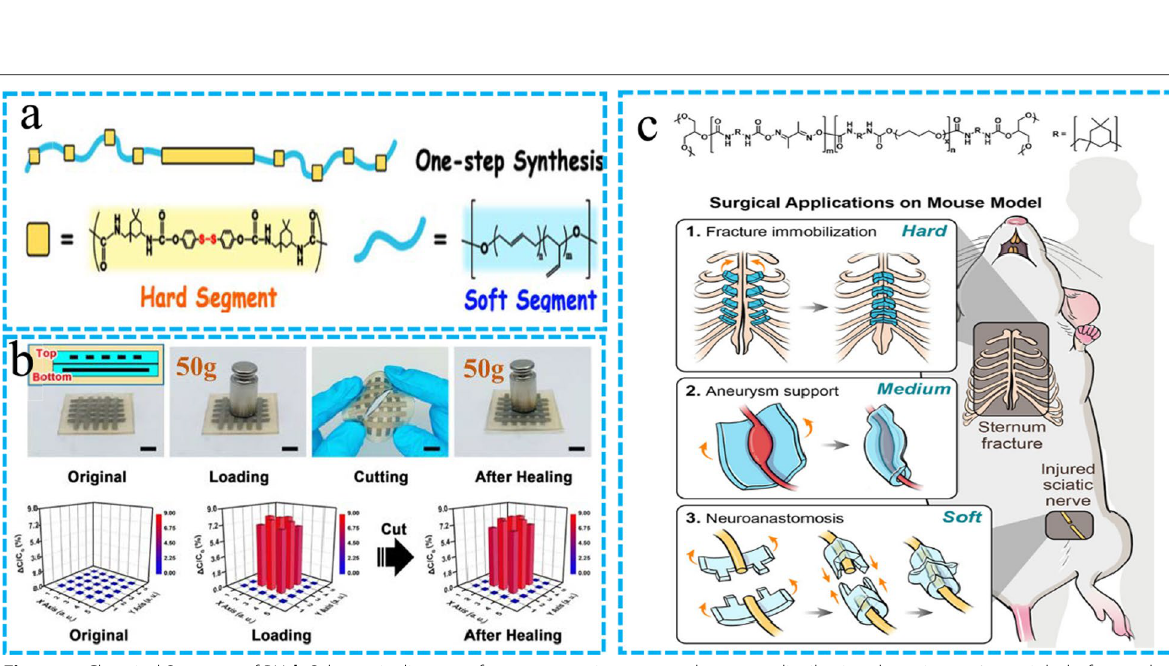
Fig. 15 a Chemical Structure of PU. b Schematic diagram of pressure sensing array and pressure distribution detecting a 50 g weight before and after self-healing. Reprinted with permission form Reference[86]. Copyright 2020, American Chemical Society. c Schematic diagram of chemical structural and biomedical applications of PU. Reprinted with permission form Reference [87]. Copyright 2021, Springer